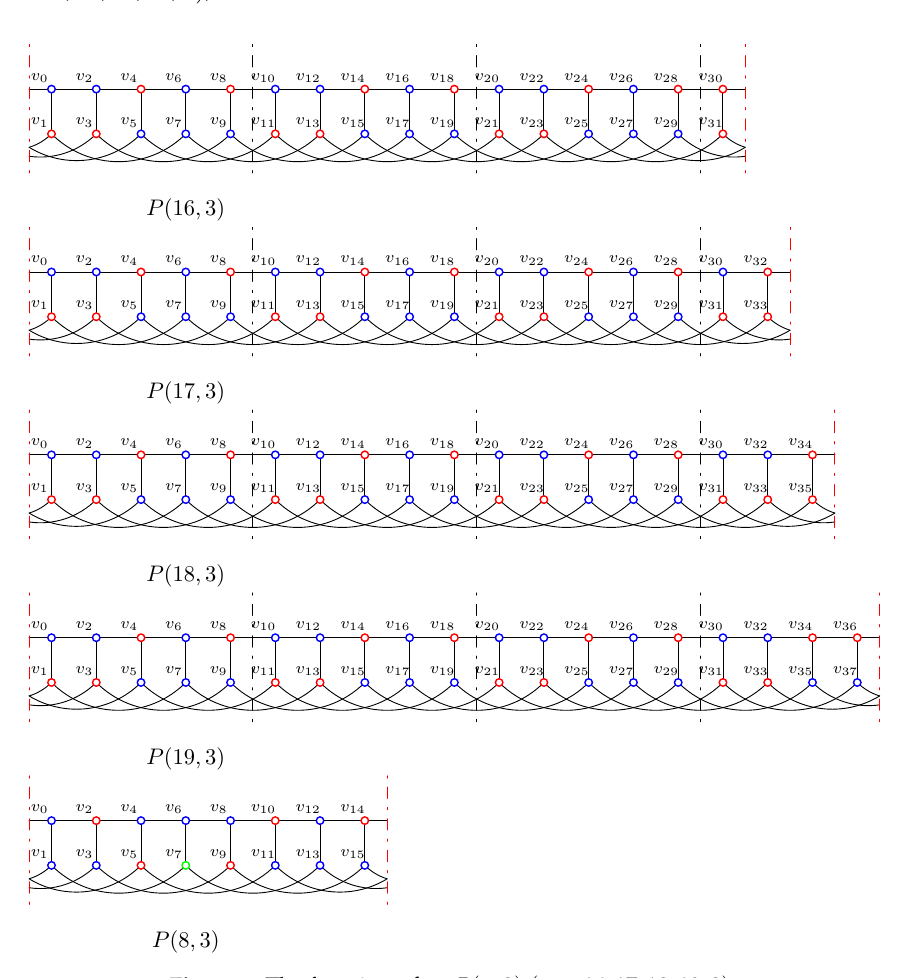
Table 1. f on P ( n ,3 ) for n